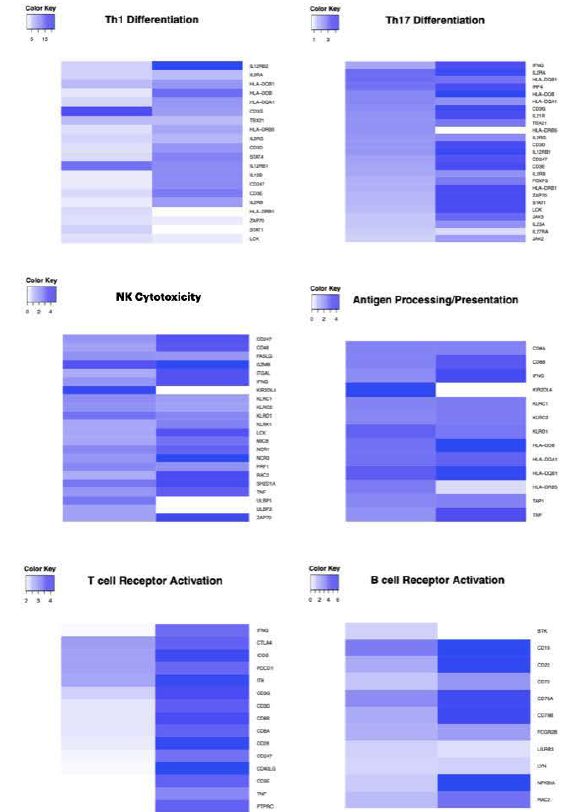
Figure 1. Immune pathways activated by iodine supplementation. The expression of genes in the I 2 group correspond to early-stage tumors and those of the Cht+I 2 group correspond to the advanced- stage tumors.A color scale (color key) specific for each pathway is depicted. The overexpressed genes for each pathway are shown in the right axis of each